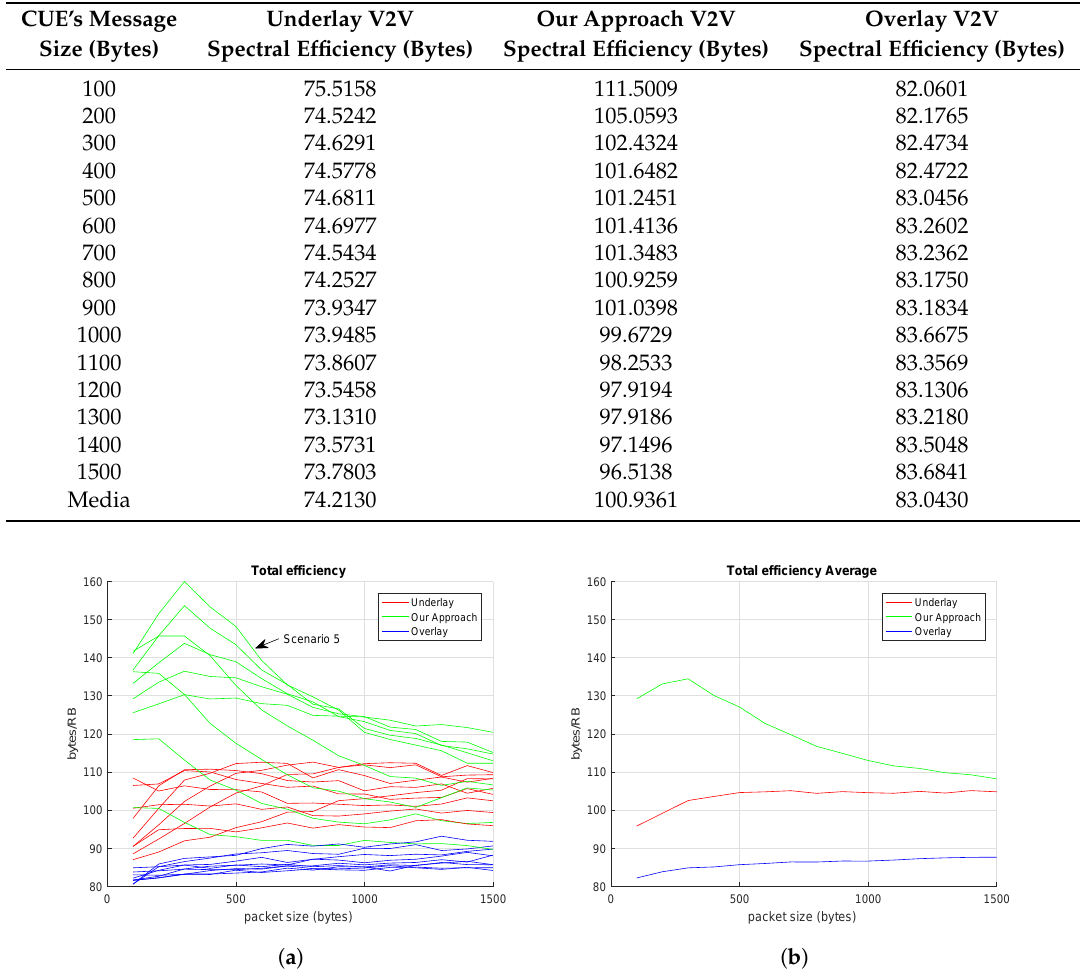
Figure 7. Spectral Efficiency offered to V-UEs based on C-UEs’ traffic pattern. ( a ) Total Average Spectral Efficiency in different scenarios; ( b ) Total Average Spectral Efficiency for all set of